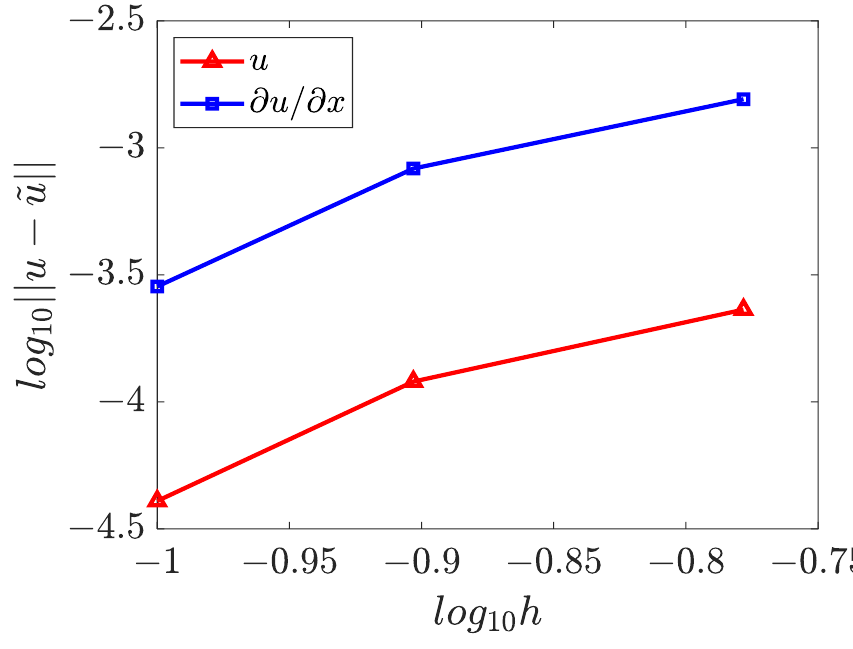
Figure 23. Convergence of the solutions for the 3D parameter identification problem in cubic domain.